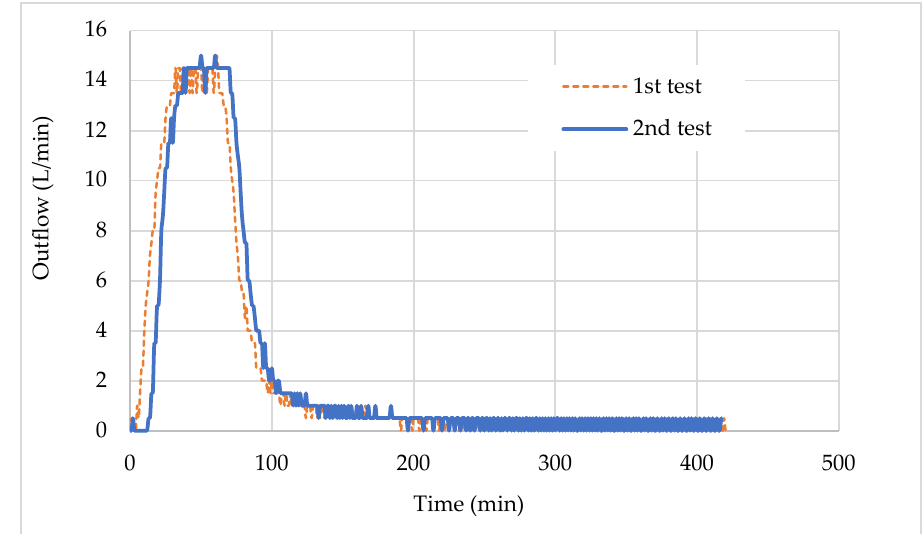
Figure 14. Rate of water outflow with respect to time. Table 5. Results for rainfall simulation test for reinforced porous asphalt pavement. Test